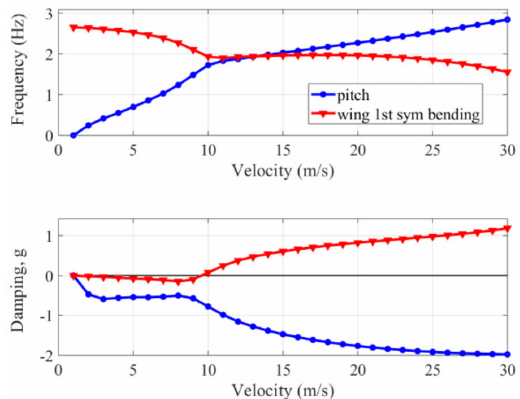
Figure 13. Revised flutter characteristics of BFF wind tunnel test UAV.